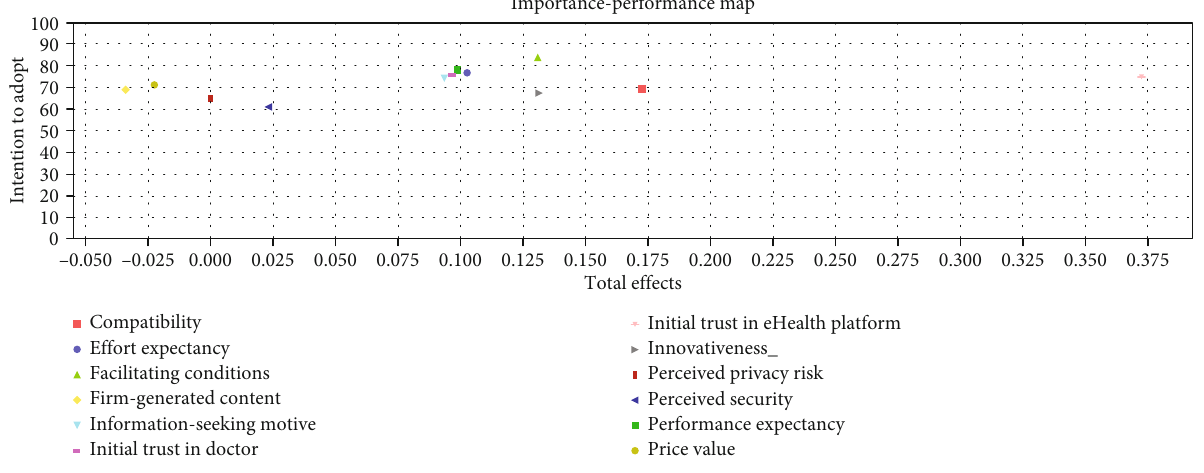
Figure 6: Importance-performance map (intention to adopt) for each construct.